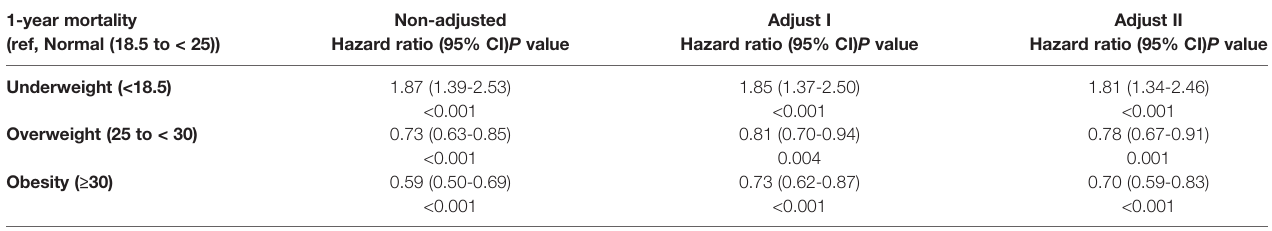
Adjusted I for gender, age, race and marital status; Adjusted II for gender, age, race, marital status, admission type, congestive heart failure, cardiac arrhythmias, valvular disease, hypertension, diabetes, chronic pulmonary disease, renal failure, liver disease, metastatic cancer, SAPS, SOFA, renal replacement therapy, mechanical ventilation and